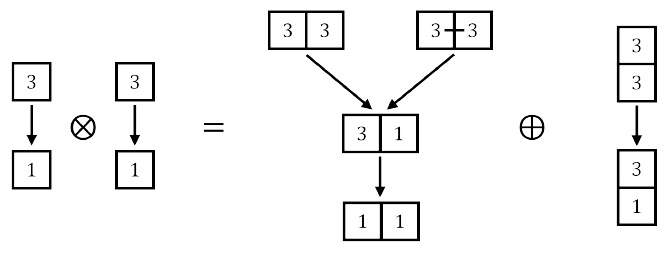
Figure 4: The rank-2 tensor representation of